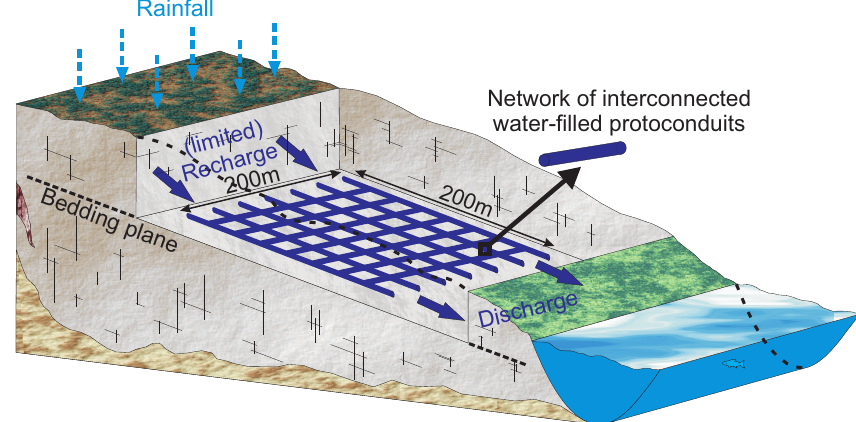
Fig. 1. Conceptual model of a conduit network, potentionally developing along a bedding plane embedded in fractured soluble rock. The modelling domain represents a two dimensional section within a limestone aquifer. Recharge into and discharge from the system is restricted to two opposite sides, whereas the remaining sides are no flow boundaries.